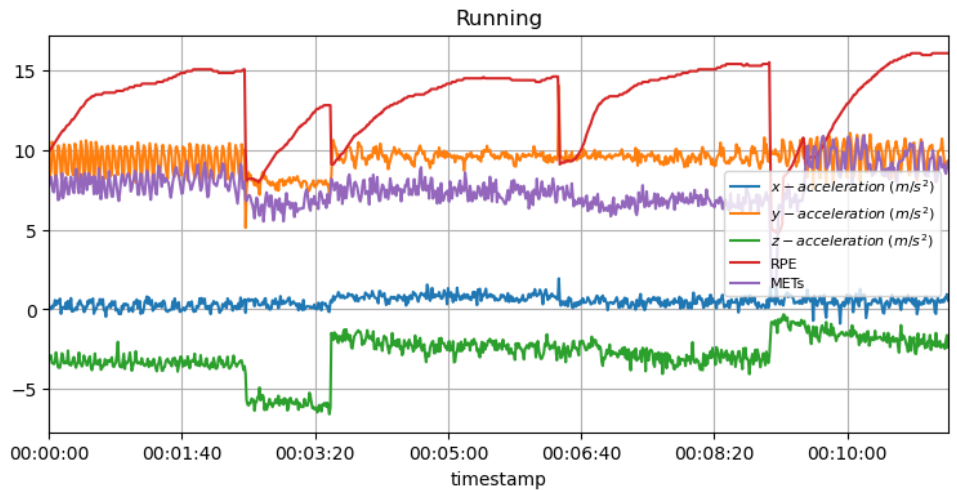
Figure 19. METs and RPE variations for running activity with acceleration